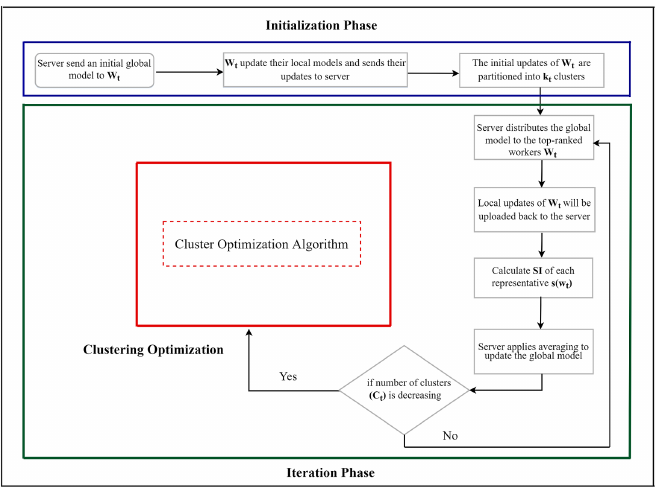
Figure 2. A schematic illustration of the entire process of the FedCO algorithm in two global communication rounds: Initialization Phase and Iteration